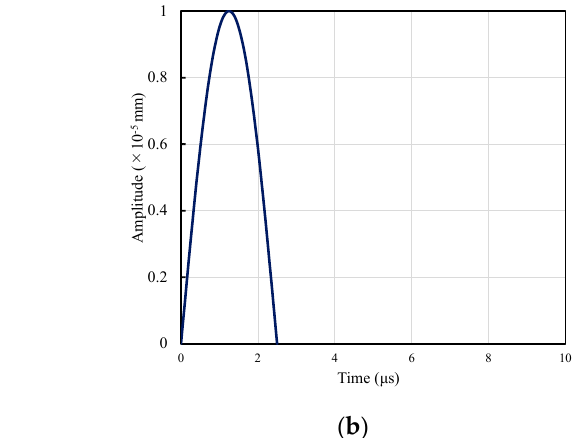
( c ) Figure 6. Comparison of the amplitude and water content: ( a ) first, ( b ) second, and ( c ) third wave. 3. Analytical Study 3.1. Model Setup The wave propagation characteristics in an inhomogeneous field are validated through numerical analysis. In this study, the analytical model for concrete is regarded as an elastic body. The numerical integration method in which the equation of motion is nu-